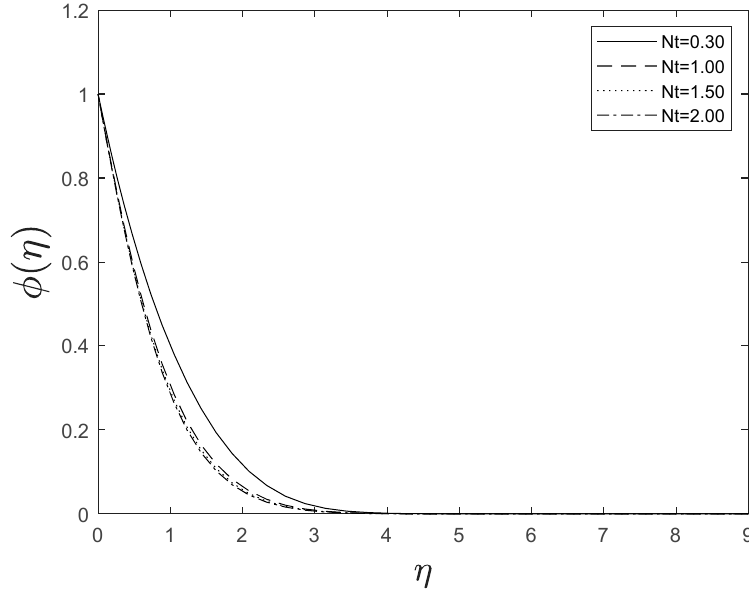
Figure 14. Effect of different values of Nt on